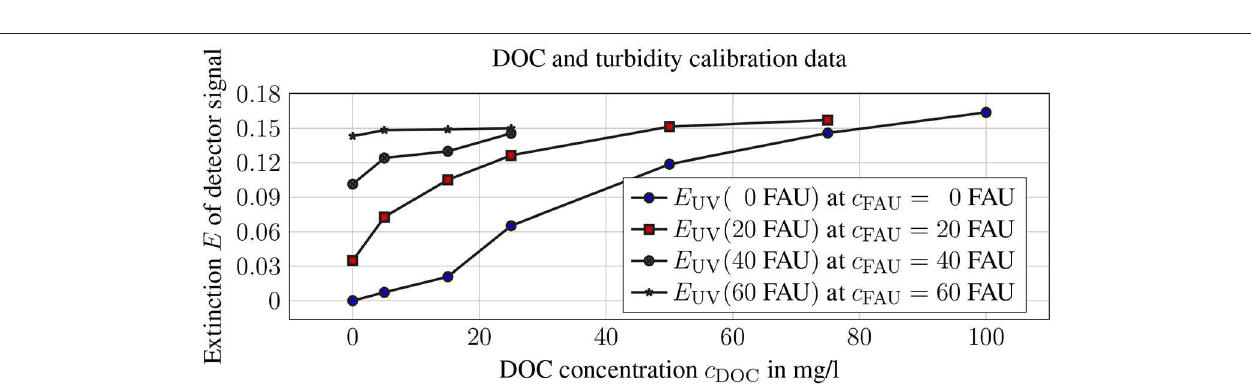
FIGURE 8 | Revised calibration points of the UV sensor unit represented as extinction E , plotted on the respective DOC concentration and corresponding turbidity. The color yellow represents high detector signals, while dark blue represents low detector signals.